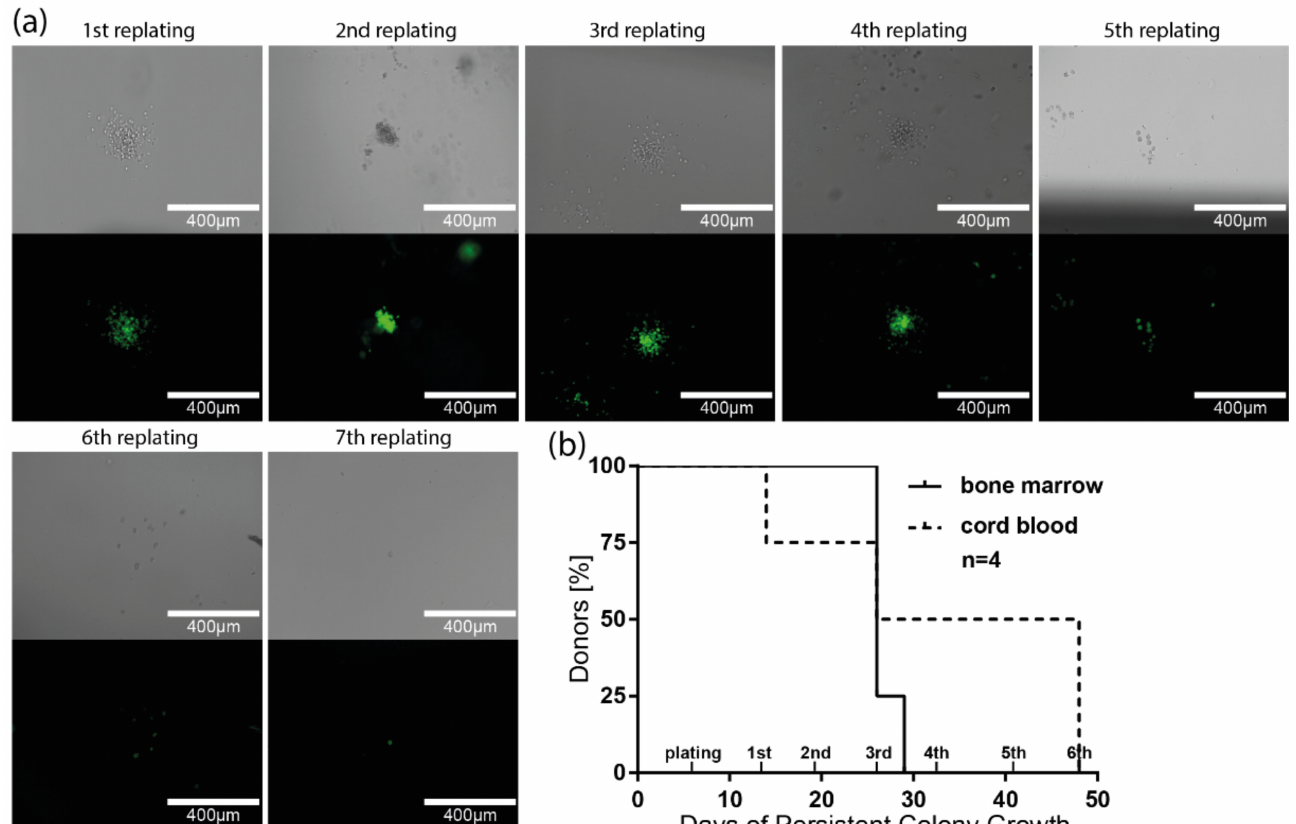
Figure 4. Replating assay and persistent colony formation of cord-blood- and bone marrow-derived Lin − cells after transduction with HIV-1 Env-pseudotyped reporter virus. Micrographs of GFP + colonies/cells after serial replating. Replating assays were initiated using Lin − cells transduced with HxB2 Env-pseudotyped GFP reporter virus and sorted at day 5 for GFP + expression. GFP + cells were seeded in CFU medium and grown for 7–8 days before colonies were picked, scattered, and replated for another 7–8 days. Replating was repeated until GFP + colony growth ceased. ( a ) Representative fluorescence micrographs of GFP + colonies grown from cord-blood-derived progenitors after serial replating steps. First micrograph was taken after initial plating before first replating. ( b ) Percentage of donors with persistent colony growth of HIV-1 reporter-virus-transduced progenitors from cord blood and bone marrow over time; n represents the number of different donors analyzed for both cord blood and bone